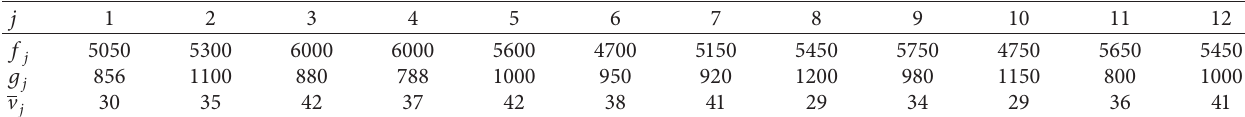
Figure 3: Relative position of the disaster site and candidate sites. Table 4: Basic parameters of emergency temporary blood supply